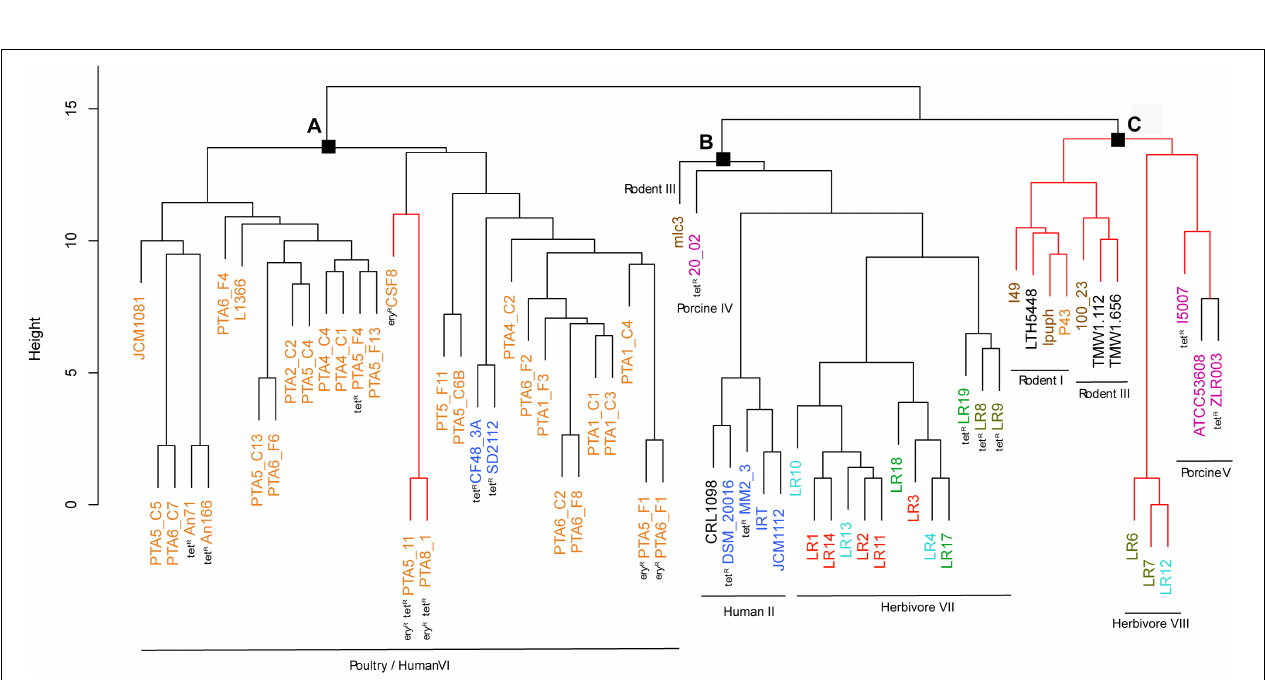
FIGURE 2 | Phylogenetic tree based on gene content matrix (presence or absence of annotated gene) of 65 L. reuteri strains from different hosts (25 genomes from this study and 40 from NCBI, Supplementary Table S1 ). Different colors represent different hosts, blue: human; yellow: chicken; pink: pig; brown: mouse/rat; light blue: cow; red: goat; green: horse; brown/green: sheep; black: sourdough. The red branches indicate the reuterin-negative strains. (A–C) indicate identified clusters. Strains which harbor AMR genes for tetracycline (tet) and erythromycin (ery) are indicated as tetR and eryR, respectively.